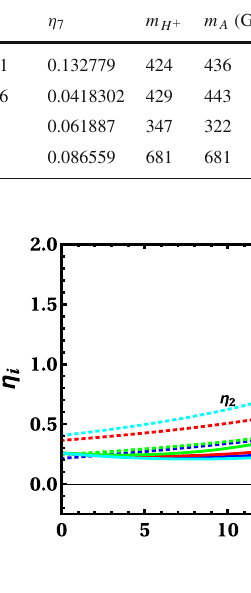
Fig. 1 The running of η 1 (solid) and η 2 (dotted) for BP a , b , c and d are shown in blue, red, green and cyan lines